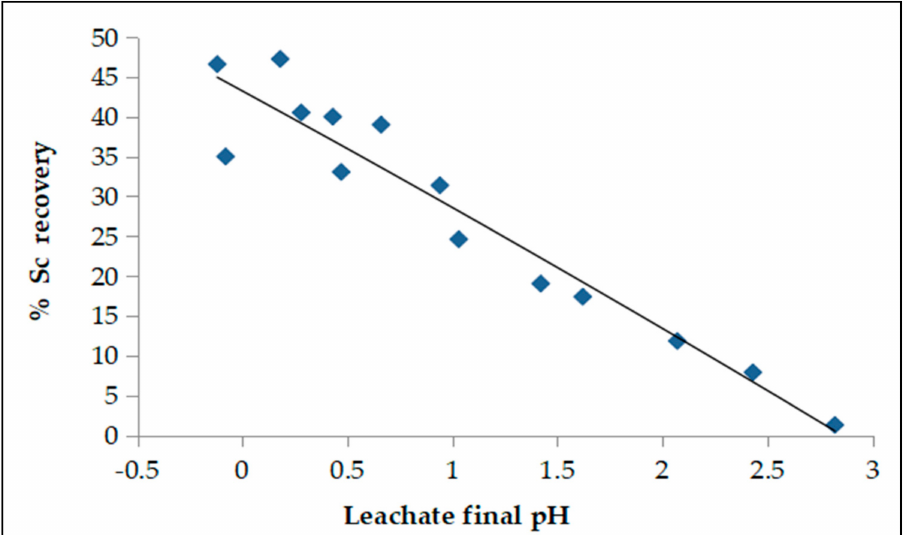
Figure 8. Effect of pH value (T = 25 ◦ C, t = 60 min).